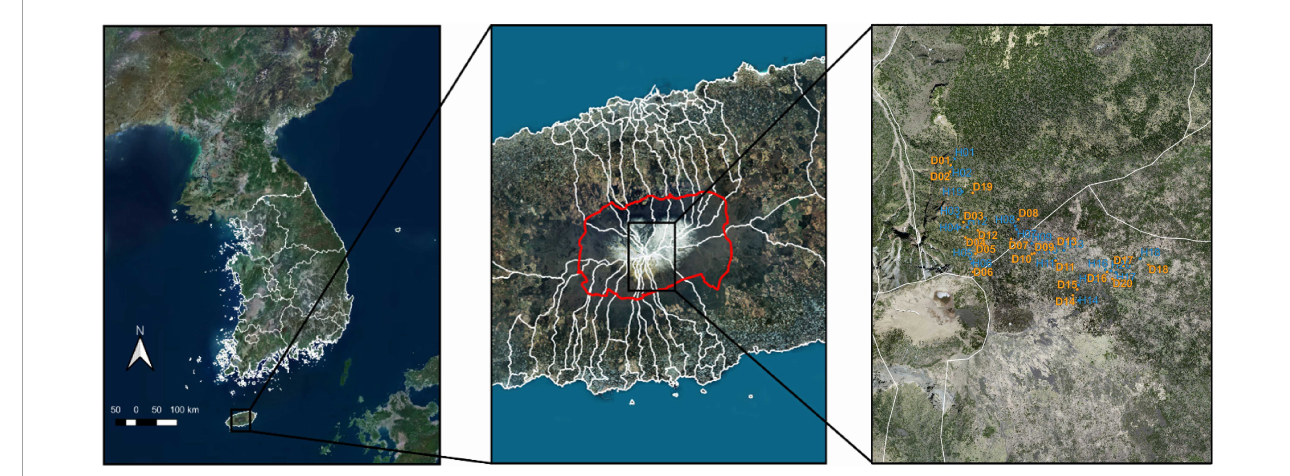
FIGURE1 Sampling site of the Korean fir tree. The sampling site is a Korean fir forest (green) near Baengnokdam Crater Lake, the summit of Mt. Hallasan. The boundaries of Mt. Hallasan National Park are marked in red. Sampling points were marked: Healthy Korean Fir (blue) and Dead Korean Fir (yellow).